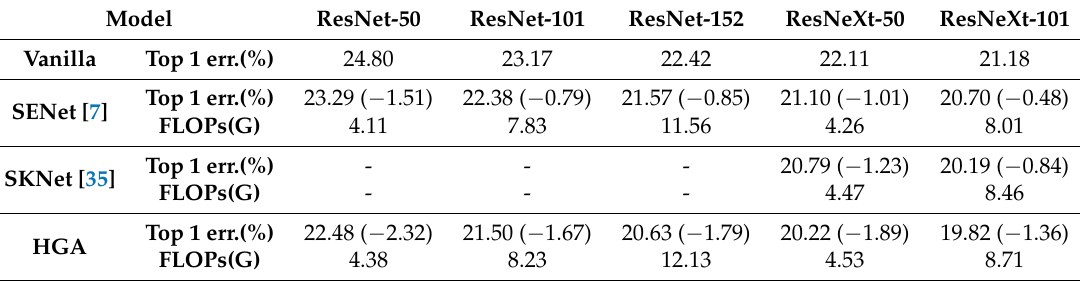
Table 3. Comparisons of different attention mechanism on ImageNet dataset.